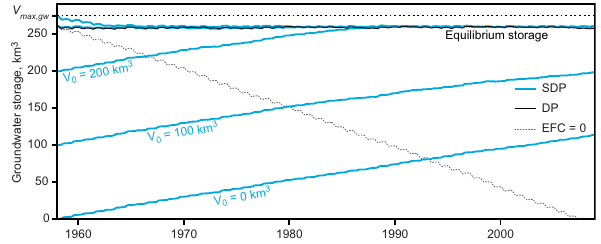
Figure 5. Simulated groundwater aquifer storage levels for 51 years of historical runoff with different initial groundwater tables (0, 100, 200, 258, and 275km 3 ) . Results for the business-as-usual scenario (EFC is disregarded) and a benchmark scenario with perfect fore- sight (DP) are also